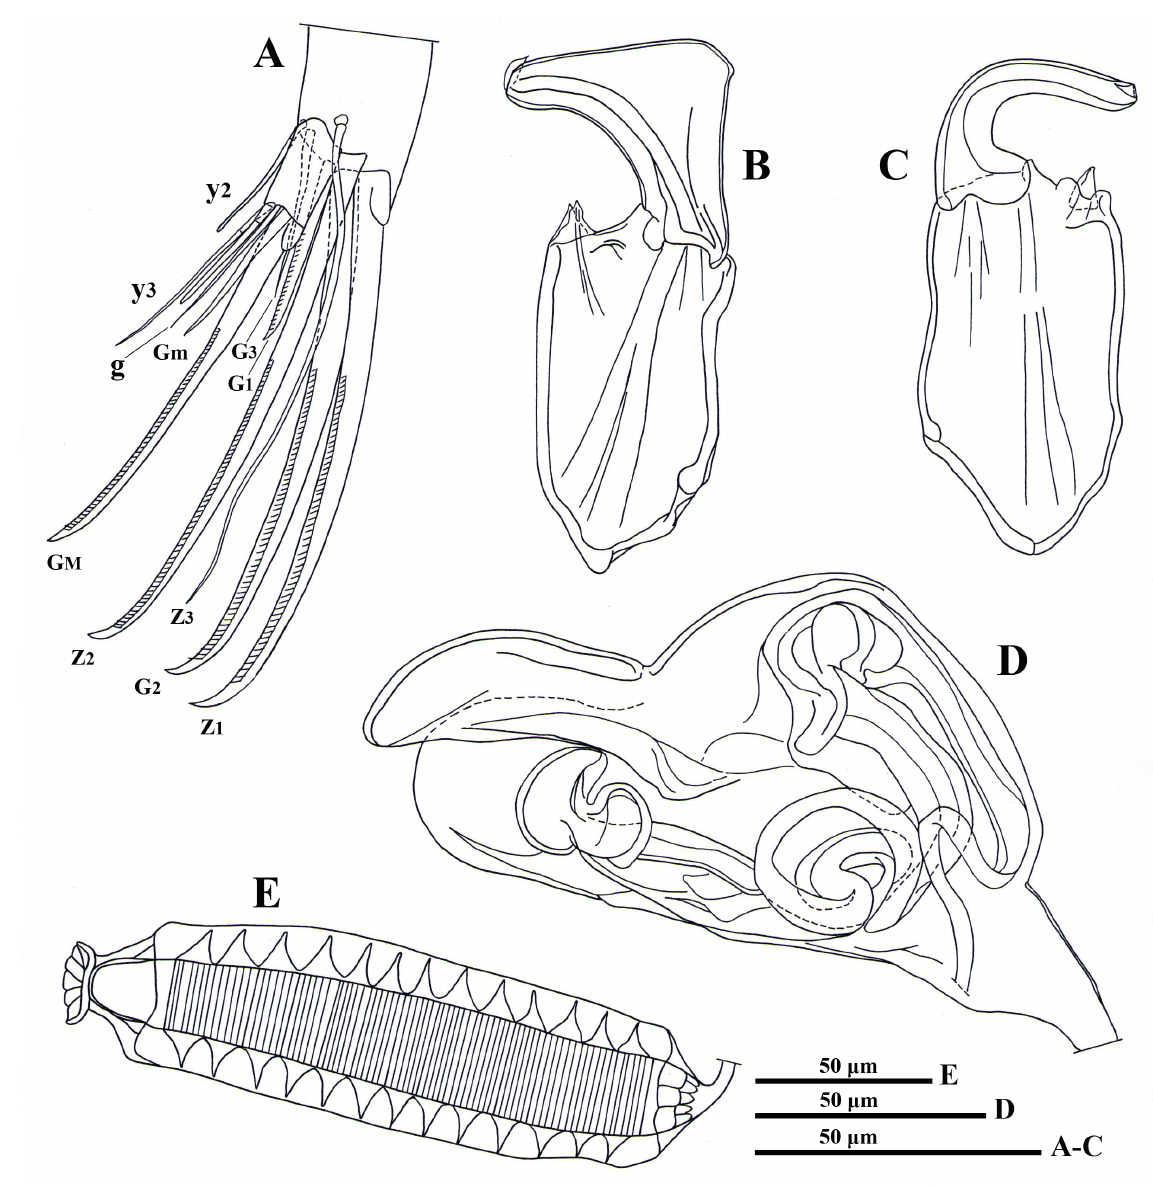
Fig. 6. Pseudostrandesia ratchaburiensis sp. nov. Allotype, ♂ (MSU-ZOC.298). A . Distal end of penultimate segment and terminal segment of A2. B . Right prehensile palp. C . Left prehensile palp. D . Hemipenis. E . Zenker’s